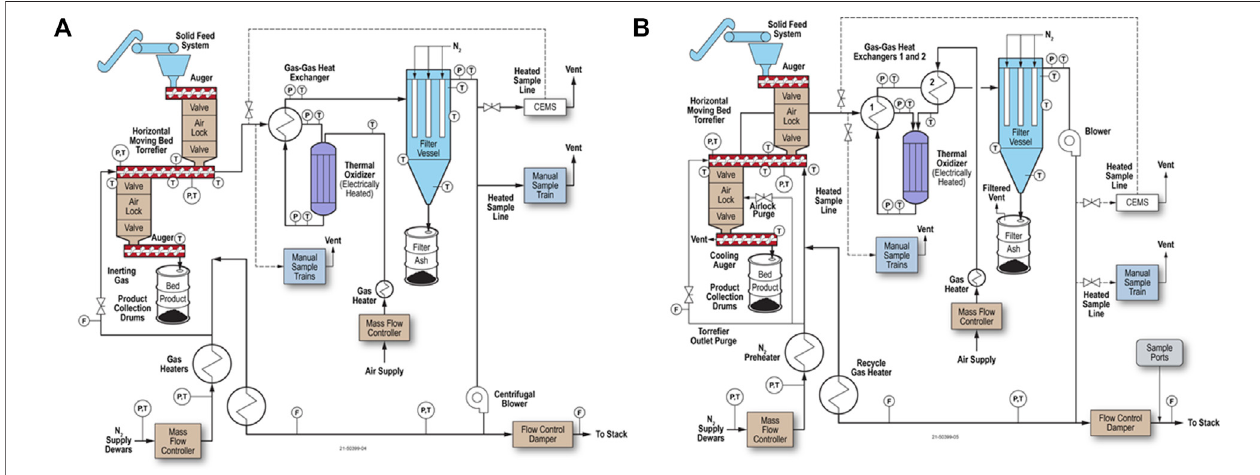
FIGURE 9 | Horizontal moving bed torrefaction system with (A) counter- fl owing gas and biomass and process gas oxidation upstream of fi ltration; and (B) co- fl owing gas and biomass and process gas oxidation upstream of fi ltration.